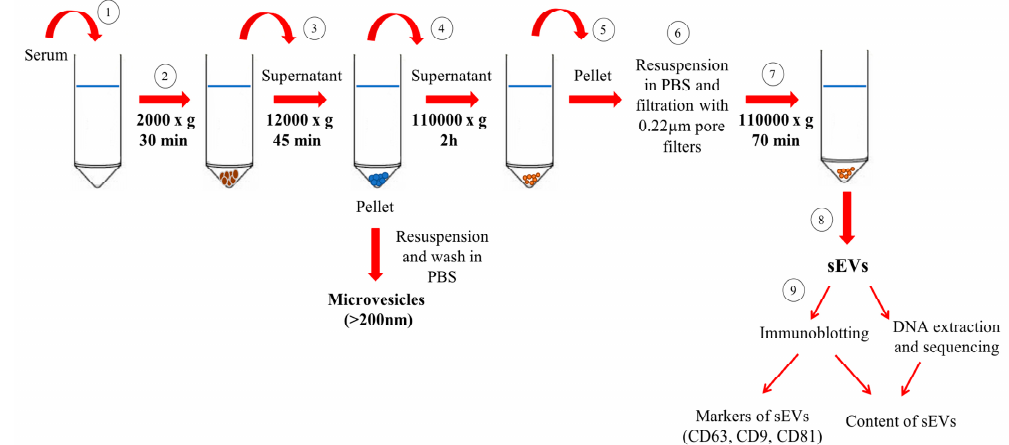
Figure 1. Schematic representation of the isolation and characterisation of small extracellular vesicles (sEVs) from serum. Serum is centrifuged at 2000 × g at 4 ◦ C for 30 min. Pellet is discarded to remove cell contamination (Steps 1 and 2) and supernatant is centrifuged at 12,000 × g at 4 ◦ C to remove apoptotic bodies, mitochondrial particles, cell debris and large vesicles (i.e., microvesicles with mean size > 200 nm) (Step 3). Supernatant from Step 3 is ultracentrifuged for 2 h at 110,000 × g at 4 ◦ C (Step 4) and the pellet is collected (Step 5), resuspended in phosphate-bu ff ered saline (PBS), filtered through a 0.22- µ m filter (Step 6) and ultracentrifuged for 70 min at 110,000 × g at 4 ◦ C to eliminate contaminant proteins (Step 7). The pellet obtained from Step 7 is resuspended in 100 µ L of PBS and represents purified sEVs (Step 8). After isolation, sEVs are analysed to confirm the presence of CD63, CD9 and CD81 markers and their content is characterised via immunoblotting and mitochondrial DNA sequencing analysis (Step 9). Table 1. Technical specifications of the primary antibodies for Western immunoblotting.